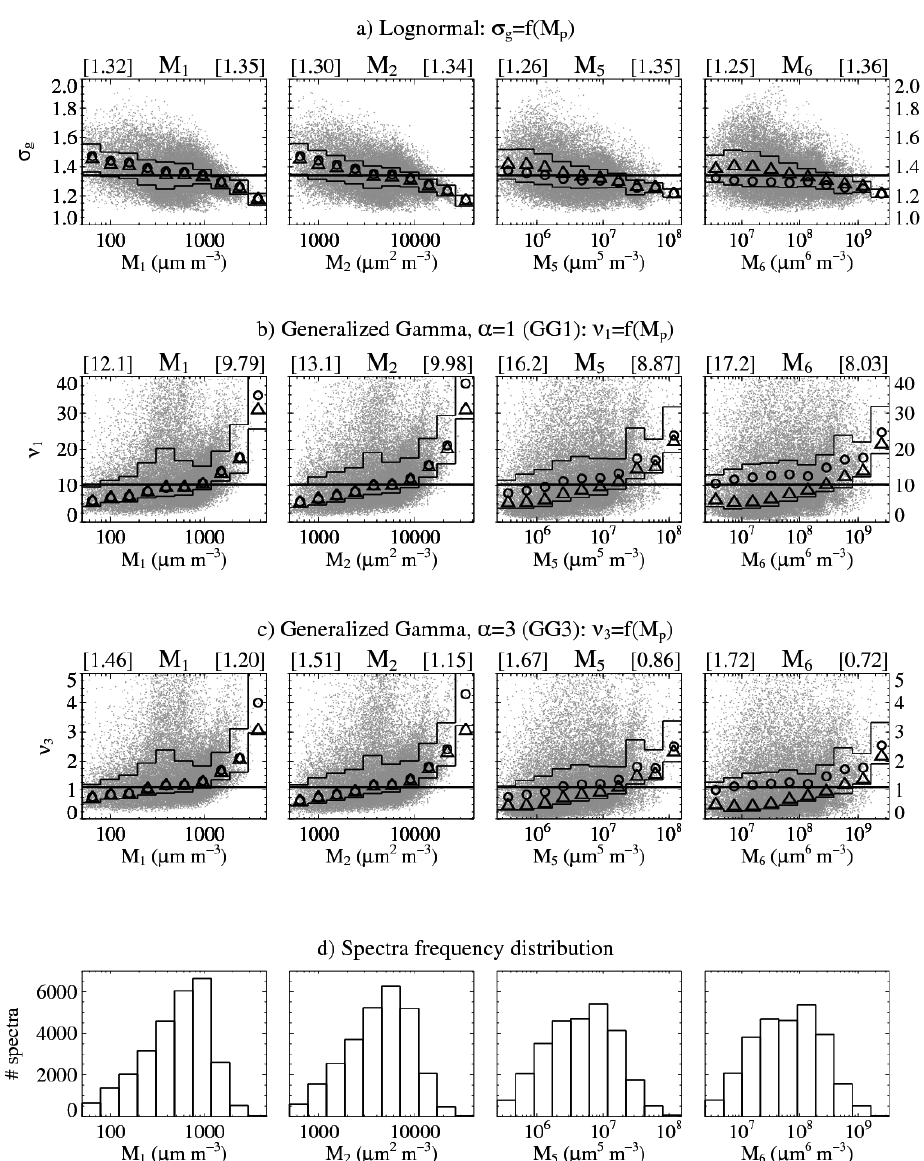
Fig. 2. Scatter-plots (grey points) of the tuning parameter values as a function, from left to right, of the M 1 , M 2 , M 5 , and M 6 moment values. The x-axis is divided in 10 classes on a Logscale. The thin lines denote the 25th and the 75th percentiles of the tuning parameter distribution in each class. The circles and triangles denote the tuning parameter value that minimizes the standard deviation of the absolute error and the geometric standard deviation of the relative error in each class, respectively. The horizontal thick line denotes the constant trade-off value of the tuning parameter. The top row is for the Lognormal function, the second and third rows are for the Generalized Gamma functions with α =1 and α =3, respectively. On top of each graph, the number in brackets on the left (right) hand side is the tuning parameter value that minimizes the absolute (relative) error over the whole range of variation of the specified moment. The fourth row shows the number of sampled spectra in each moment class.